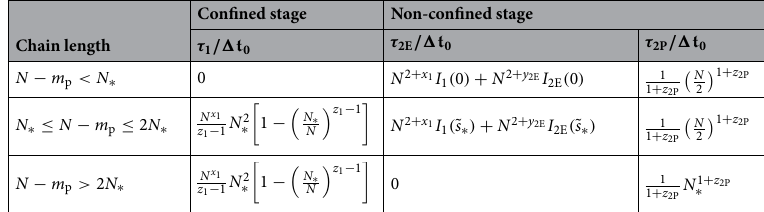
Table 1. Predicted time scales τ 1 , τ 2E , and τ 2P in the main ejection stage. Three situations are